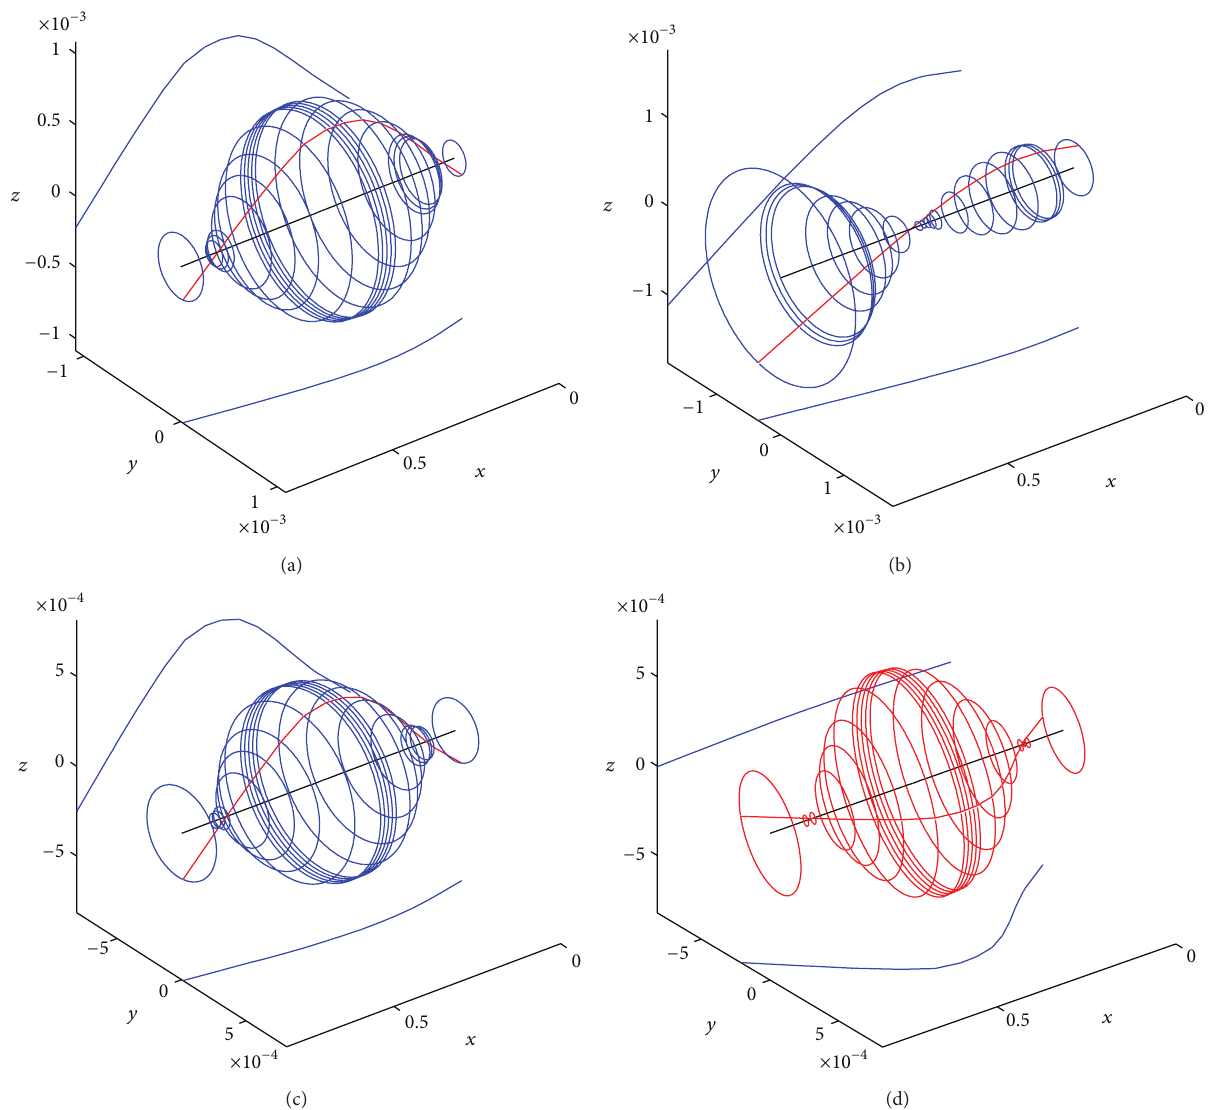
Figure 7: Natural modes of configuration A for a rotational speed of 40 Hz: (a) bearing 2 fluid frequency at 21.83 Hz; (b) bearing 1 fluid frequency at 20.85 Hz; (c) first forward flexural natural frequency at 25.74 Hz; (d) first backward flexural natural frequency at